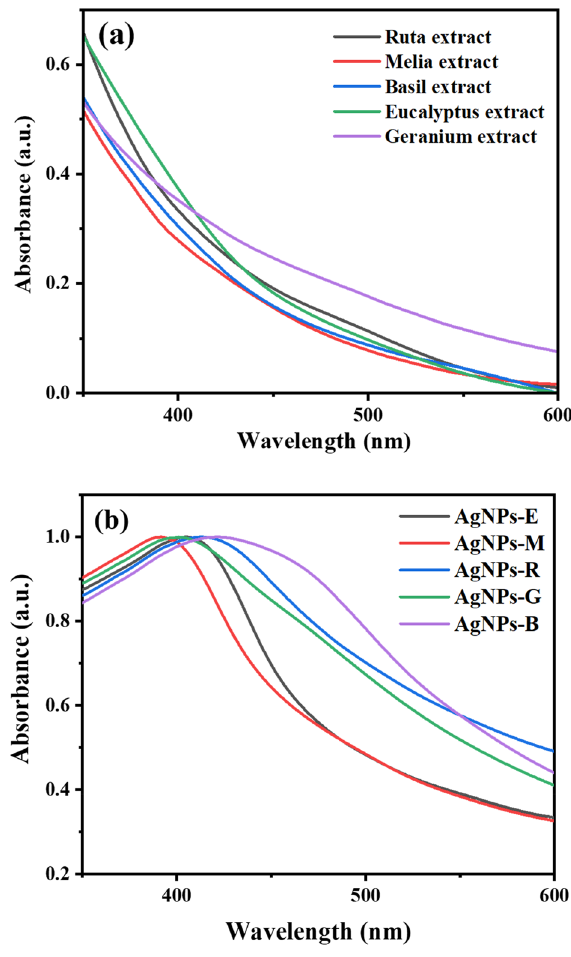
Figure 1. UV–visible absorption spectra (normalized) of: ( a ) leaf extracts of Eucalyptus , Melia , Ruta , Geranium , and Basil ; ( b ) biosynthesized